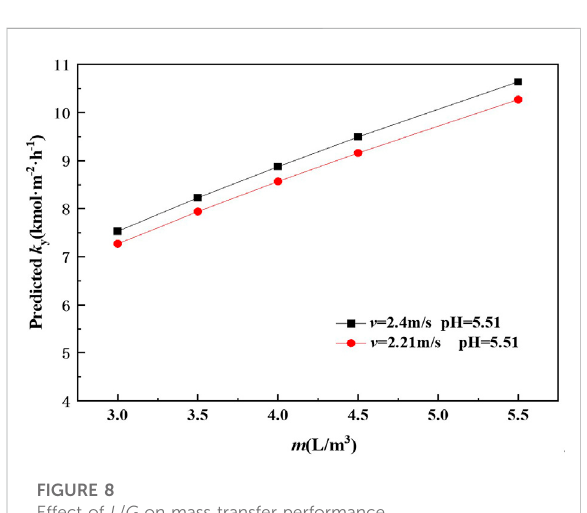
FIGURE 8 Effect of L / G on mass transfer performance.